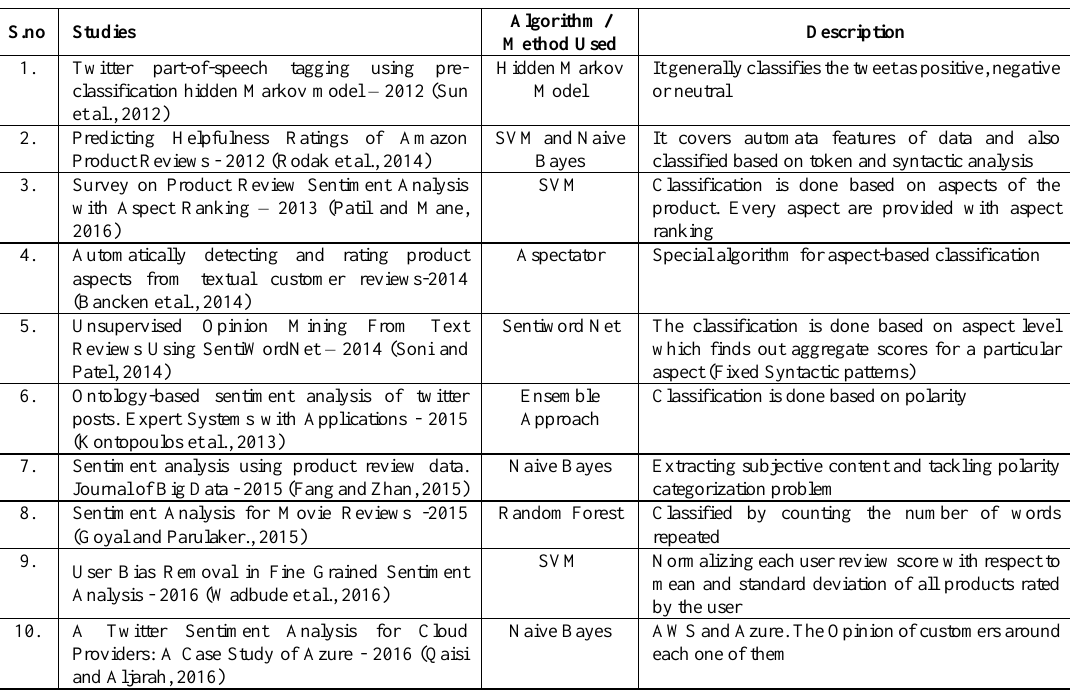
Table 1. Study of sentiment